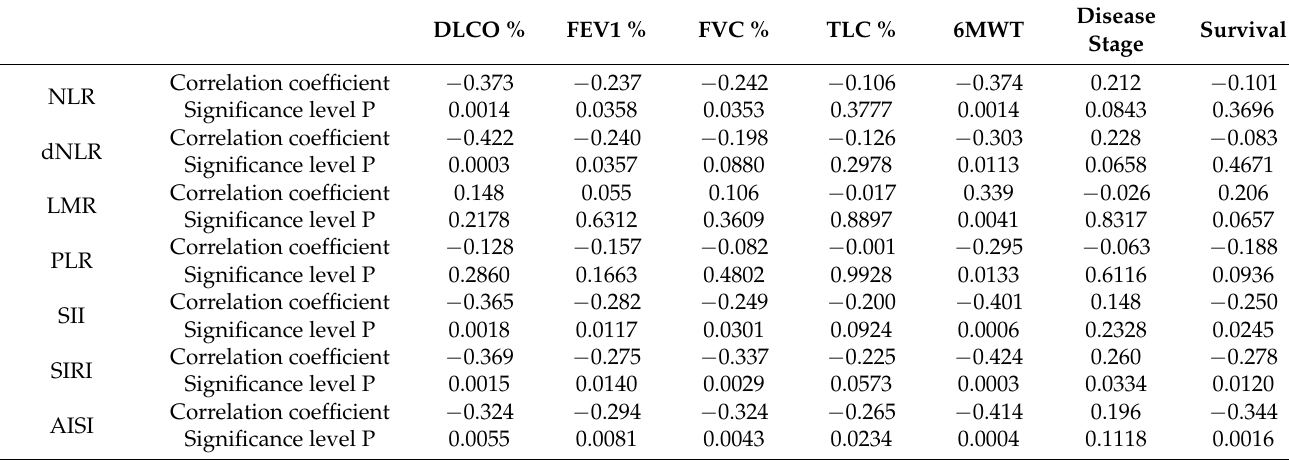
Table 3. Relationships between combined blood cell count indexes and clinical